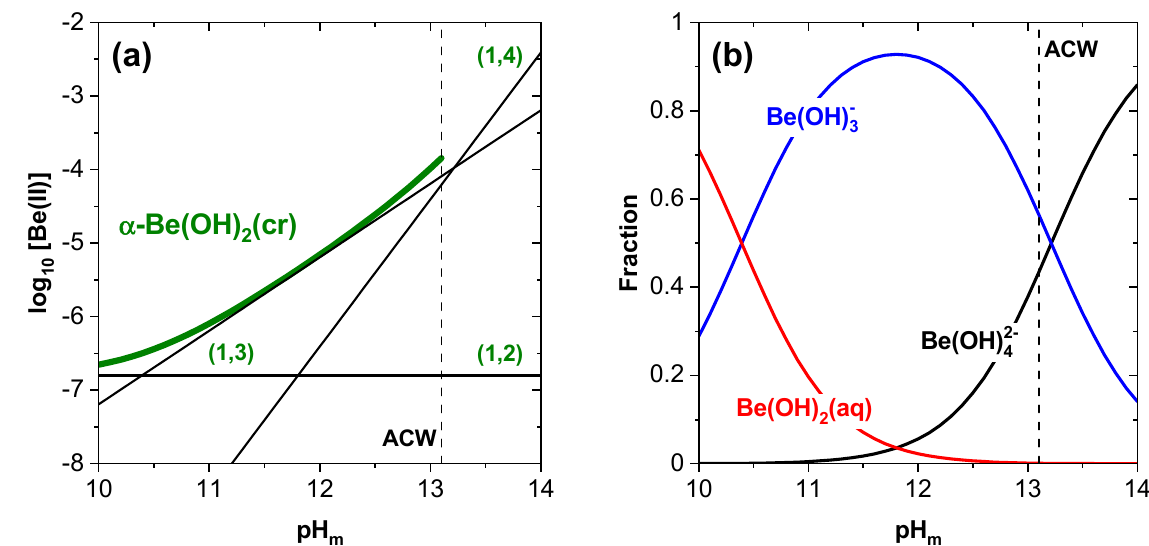
Figure 1. ( a ) Solubility and ( b ) fraction diagrams of Be(II) within 10 ≤ pH m ≤ 14 calculated for the pore water composition of ACW using the chemical, thermodynamic, and activity models reported in [13].